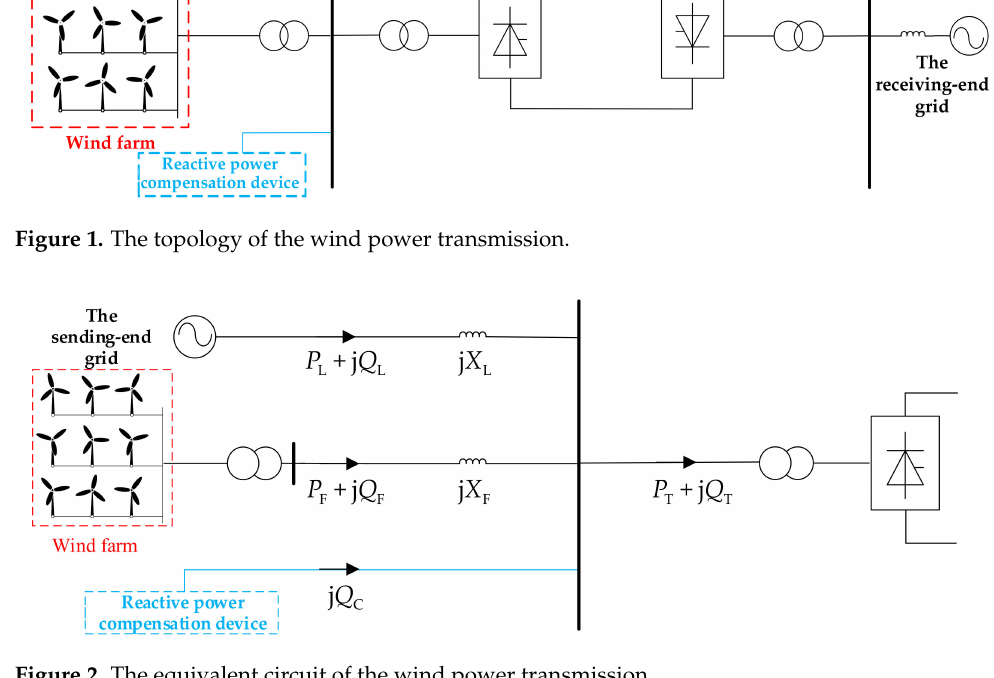
Figure 2. The equivalent circuit of the wind power